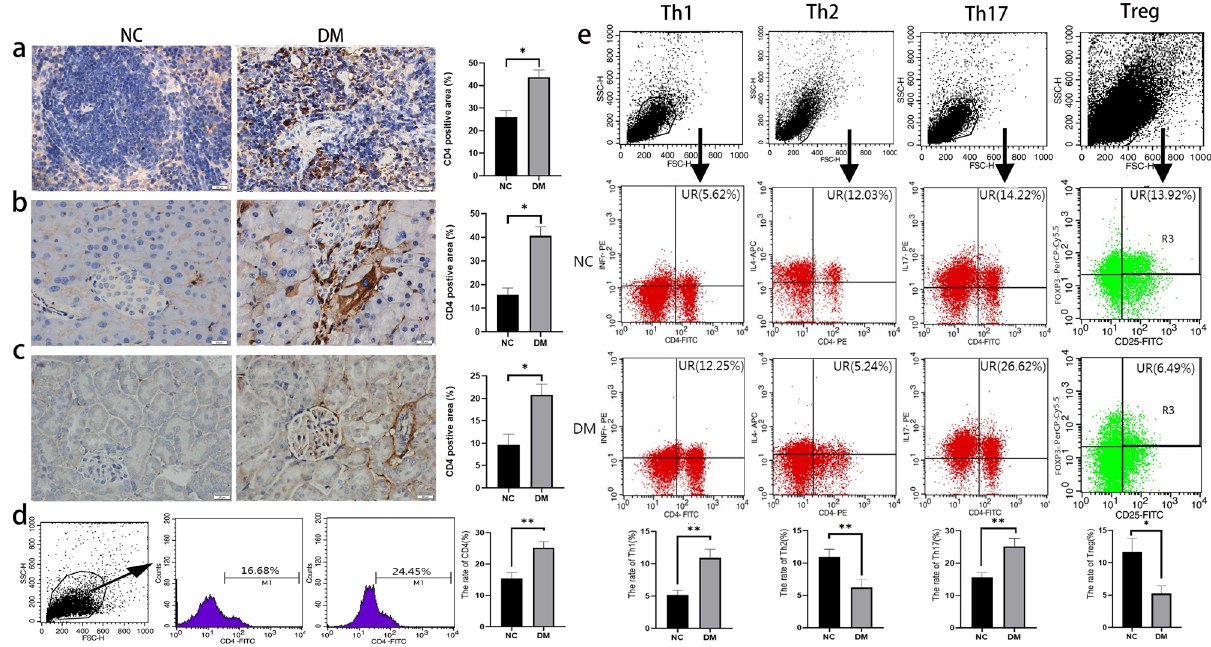
Figure 2. The change of the CD4 + T cells and its subtypes in different organs. CD4-positive cells were detected by Immunohistochemical staining in different organs and their positive area was evaluated, spleen ( a ), pancreas ( b ), kidney ( c ). Changes in the proportion of CD4 + T cells (CD4 + ) in the spleen of each group was determined by Flow cytometry ( d ). Changes in the proportion of CD4 + T cells’ subtypes in the spleen of each group was determined by Flow cytometry. Th1 cells: CD4 + and IFN-γ + ; Th2 cells: CD4 + and IL-4 + ; Th17 cells: CD4 + and IL-17 + ; Treg cells: CD4 + , CD25 + and Foxp3 + ( e ). Scale Bar = 20 μm, * P < 0.05, ** P < 0.01. NC, normal control; DM, diabetes mellitus.